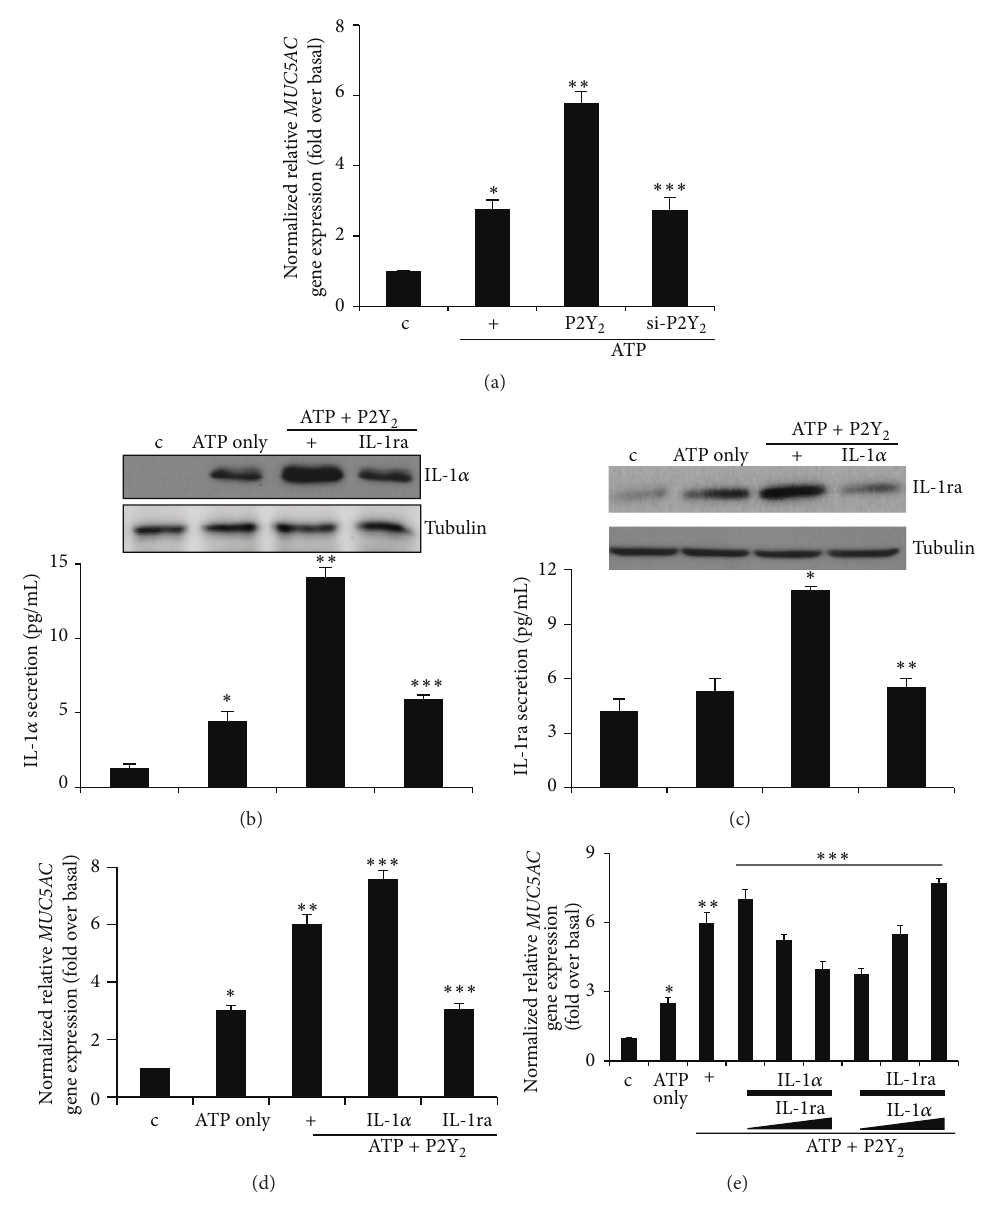
Figure 2: IL-1ra inhibits IL-1 𝛼 -induced MUC5AC gene expression via inhibiting IL-1 𝛼 secretion and overproduction. (a) Cells were transfected with either a construct driving the expression of wild-type P2Y 2 or siRNA specific for P2Y 2 . Cells were then treated with ATP for 24 hours prior to the generation of total cell lysates, and then qRT-PCR for MUC5AC transcript was performed. ∗ 𝑝 < 0.05 compared to the control, ∗∗ 𝑝 < 0.05 compared to ATP only, and ∗∗∗ 𝑝 < 0.05 compared to ATP/P2Y 2 -treated cells. (b) After transfection with wild-type P2Y 2 or siRNA-P2Y 2 , the cells were subsequently treated with IL-1ra (50 ng/mL) for 4 hours prior to treatment with ATP for 4 hours. IL-1 𝛼 production/secretion was measured by Western blot and ELISA, respectively, using the identical set of samples. Values shown represent the means ± SDs of three technical replicates from a single experiment. Two additional experiments showed similar results. ∗ 𝑝 < 0.05 compared to the control, ∗∗ 𝑝 < 0.05 compared to ATP only, and ∗∗∗ 𝑝 < 0.05 compared to ATP/P2Y 2 -treated cells. (c) Cells were transfected with either a construct driving the expression of wild-type P2Y 2 or siRNA specific for P2Y 2 . The cells were subsequently treated with IL-1 𝛼 (50ng/mL) for 4 hours prior to treatment with ATP for 4 hours. IL-1ra production/secretion was measured by Western blot and ELISA. Values shown represent the means ± SDs of three technical replicates from a single experiment. ∗ 𝑝 < 0.05 compared to ATP only and ∗∗ 𝑝 < 0.05 compared to ATP/P2Y 2 -treated cells. (d) After transfection with wild-type P2Y 2 , the cells were subsequently treated with either IL-1ra (50 ng/mL) or IL- 1 𝛼 (50 ng/mL) for 4 hours prior to treatment with ATP for 24 hours. qRT-PCR for MUC5AC transcript was performed. ∗ 𝑝 < 0.05 compared to the control, ∗∗ 𝑝 < 0.05 compared to ATP only, and ∗∗∗ 𝑝 < 0.05 compared to ATP/P2Y 2 -treated cells. (e) After transfection with wild-type P2Y 2 , the cells were treated with both IL-1 𝛼 (50 ng/mL) and IL-1ra (0, 100, 150ng/mL) or both IL-1ra (50ng/mL) and IL-1 𝛼 (0, 100, 150ng/mL) for 4 hours prior to treatment with ATP for 24 hours. qRT-PCR for MUC5AC transcript was performed. ∗ 𝑝 < 0.05 compared to the control, ∗∗ 𝑝 < 0.05 compared to ATP only, and ∗∗∗ 𝑝 < 0.05 compared to ATP/P2Y 2 -treated cells. Data shown are representative of three independent